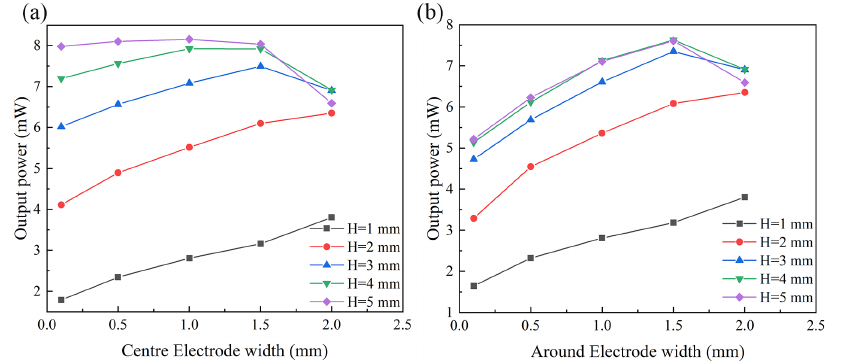
Figure 3. Relationship between ( a ) the central electrode’s width, ( b ) the surrounding electrode’s width, and the output